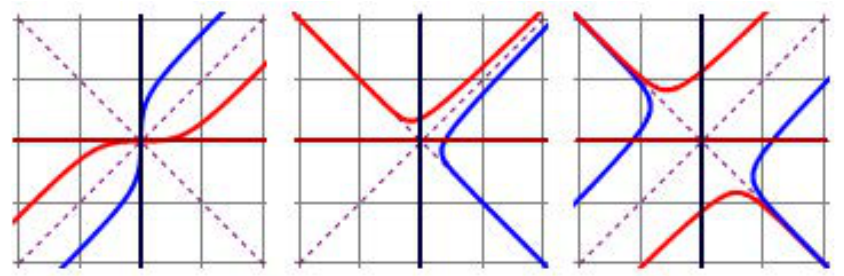
Fig. 5. Special elastic curves σ = 1,0, − 1 (blue, spacelike; red,